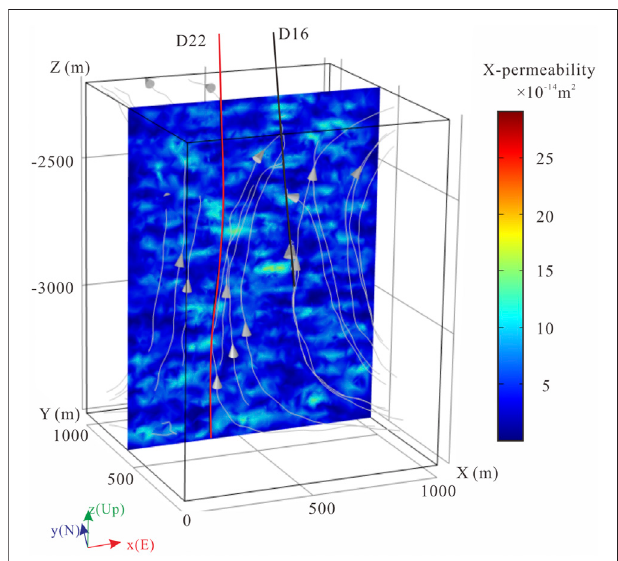
FIGURE 10 | Calculated permeability in the x direction and the pumping streamline